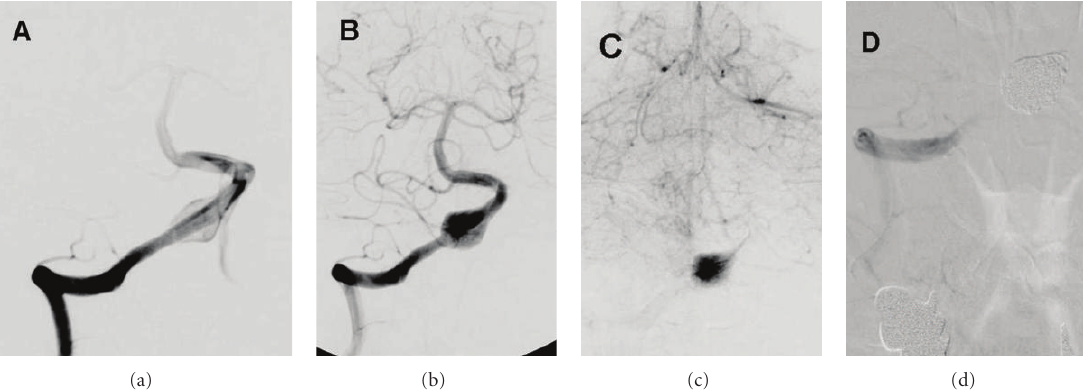
Figure 2: Right vertebral angiogram ((a): early arterial phase, (b): slightly late arterial phase, (c): late arterial phase) showing retrograde inflow into the pseudolumen. Right vertebral angiogram (d) after coil embolization at the dissection site showing complete occlusion of the aneurysm.